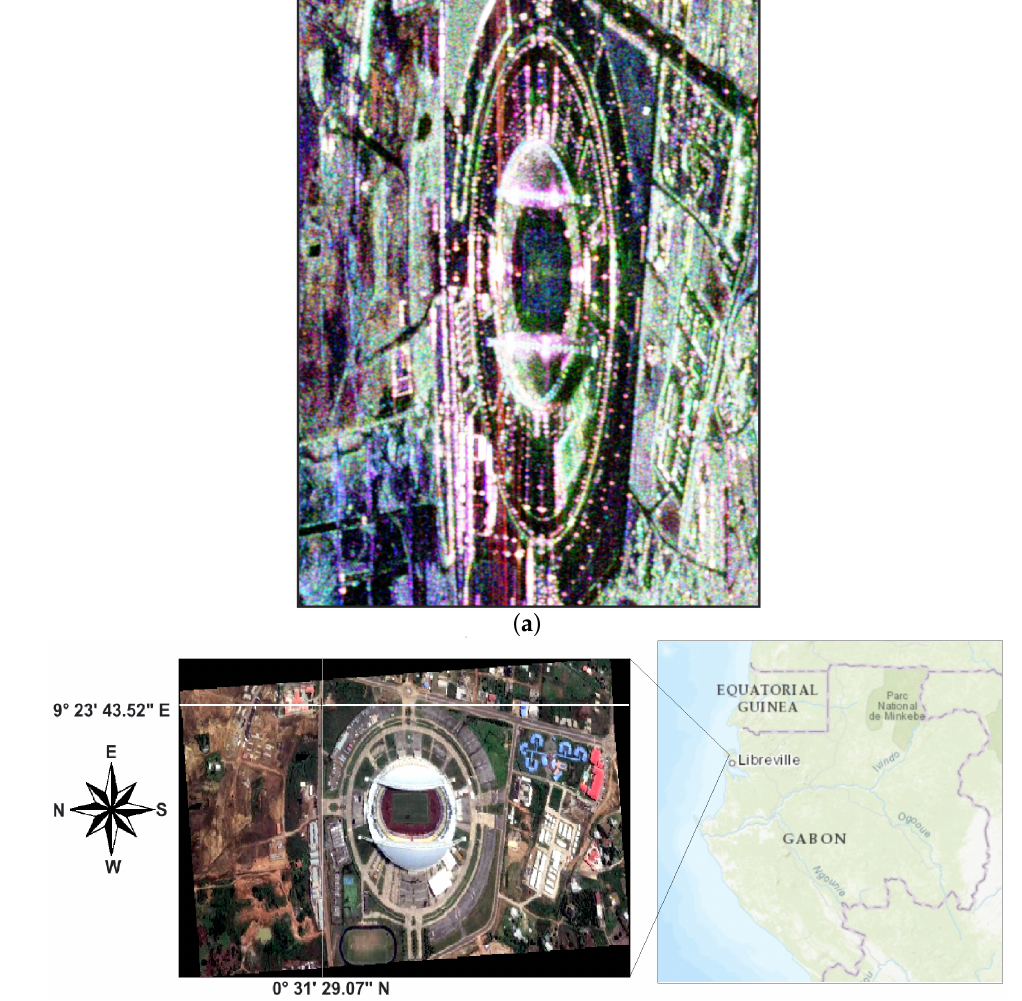
Figure 6. Information about the data set and the study area in Mondah, Gabon. ( a ) The Pauli color composite of the polarimetric UAVSAR master image provided by NASA Jet Propulsion Laboratory (JPL), accessible via (https://uavsar.jpl.nasa.gov, accessed on 13 December 2021). ( b ) Location of the study area on the map of Gabon (right) and the georeferenced optical image of the test area (left) (courtesy of Google